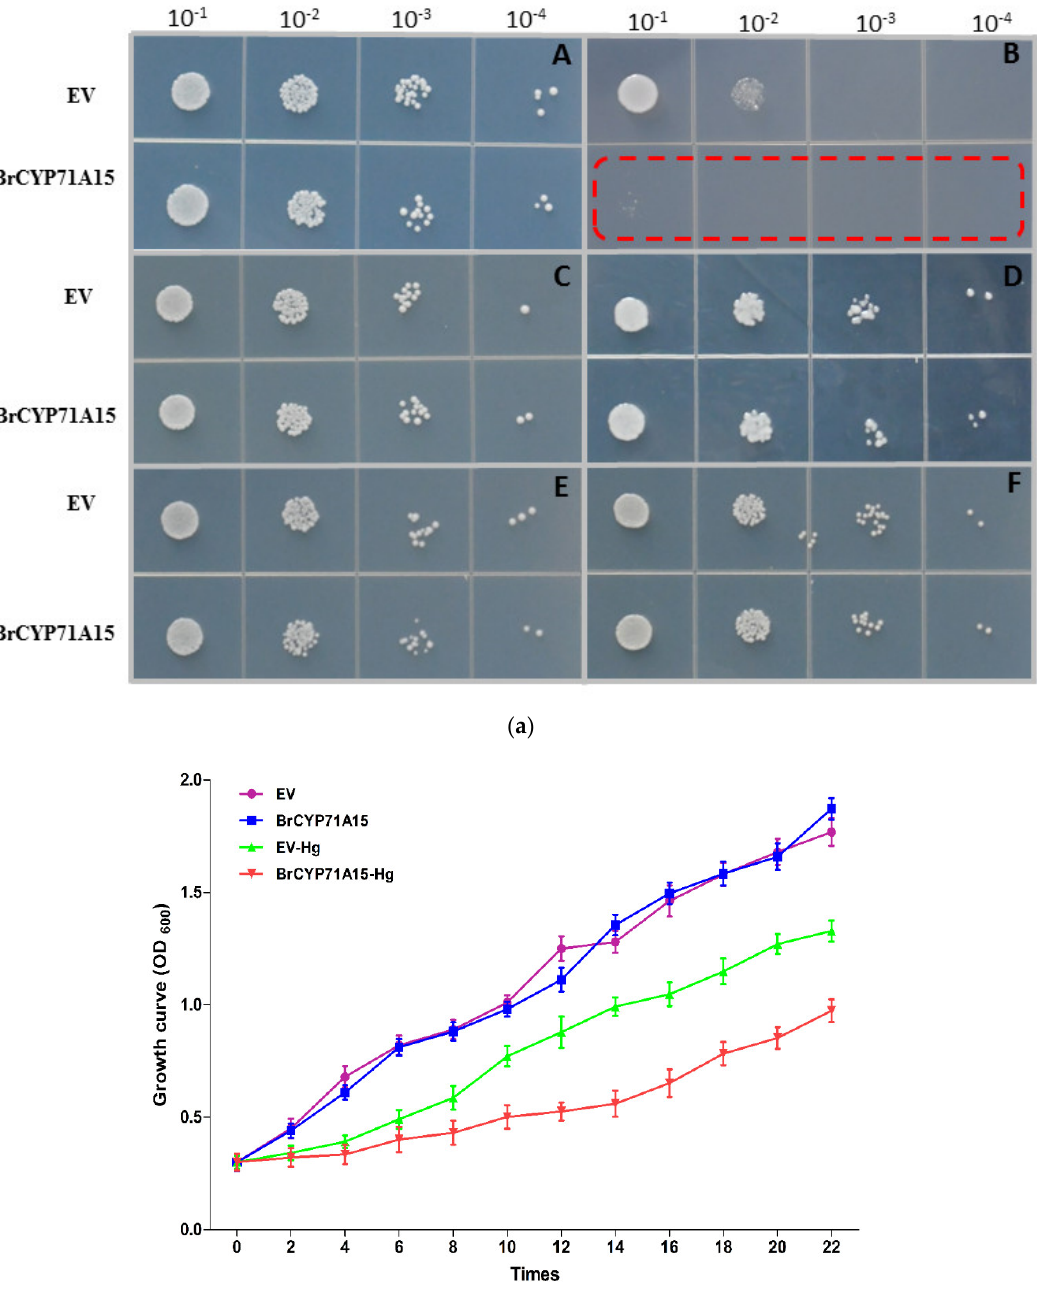
Figure 6 . ( a ) The BrCYP71A15 response to heavy metal stress tolerance in yeast. Empty vector (yeast wild-type) and BrCYP71A15 OE cells were grown in URA liquid medium for 24 h at 30 °C. OD600 was adjusted to 0.3, and the cells were subjected to different types of abiotic stresses, including URA (Control) (A), Hg (B), Cd (C), Al (D), Cu (E) and NaCl (F). The upper mentioned folds represent the serial 10-fold dilution (the starting concentration (OD 600 ) is 0.3. All experiments are repeated three times. ( b ) The growth curves of BrCYP71A15 -overexpressing cells under 100 mM Hg stress. Yeast cells with EV (empty vector (Yeast WT)) and expressing BrCYP71A15 were grown at 30 °C. Cell density was monitored at 0, 2, 4, 6, 8, 10, 12, 14, 16, 18, 20, 22 and 24 h after the treatment. Error bar represents the deviation of three independent replications.